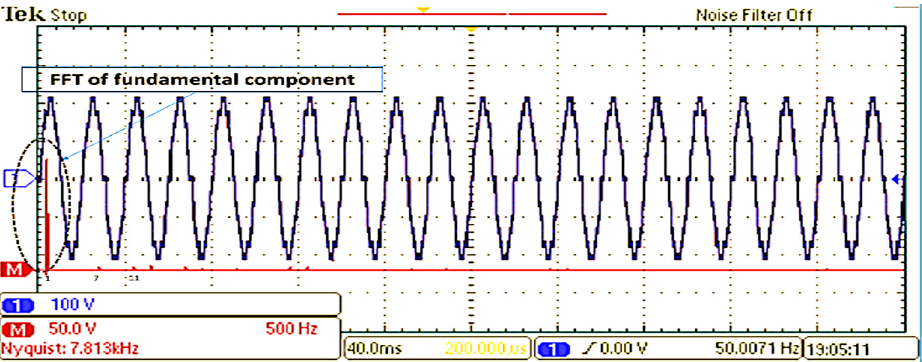
Figure 15. Output line voltage and its harmonic spectrum in red color for no load condition ( M i = 0.92).